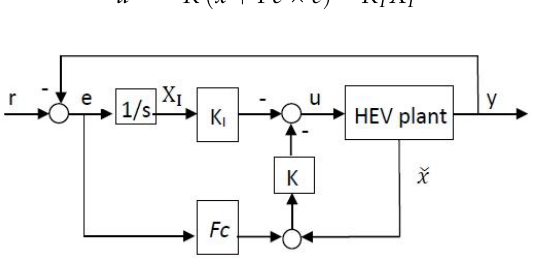
8 of 14 Figure 4. Block diagram for the HEV longitudinal speed control with robust feedback controller. 3.2. Fuzzy Logic Forward Compensator Design For accurate speed tracking, we need a controller that can exhibit robustness in stability, as well as in tracking performance. In Section 3.1, we complete the design of the optimal linear quadratic (LQ) feedback controller with robustness. However, neglecting the nonlinearities of the system may result in an LQ controller with poor tracking performance. Combining the forward and feedback controllers can therefore satisfy the performance requirements.